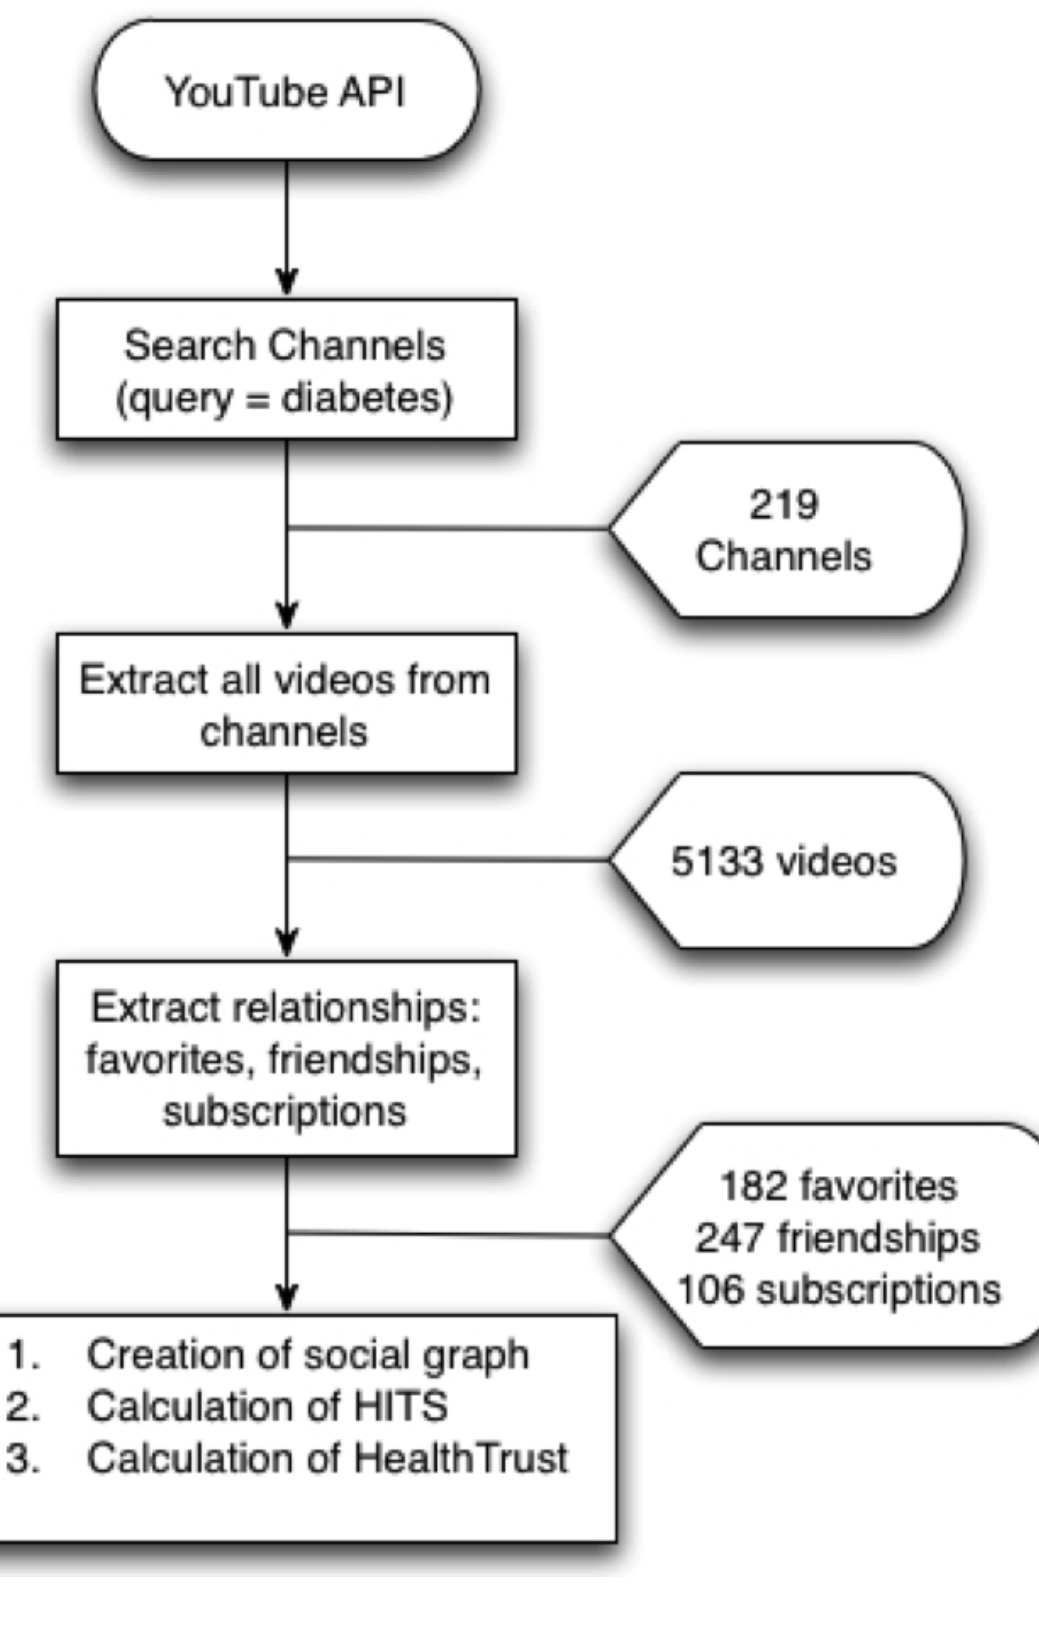
Figure 7. Data extraction in the study of diabetes channels and HealthTrust. API = application programming interface; HITS = hyperlink-induced topic